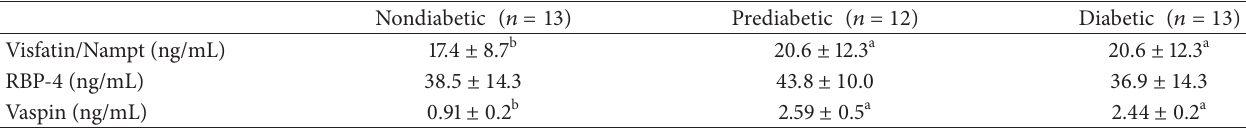
Table 2: Visfatin/Nampt, vaspin, and RBP-4 protein concentrations in plasma ¥ . Nondiabetic (𝑛 = 13)